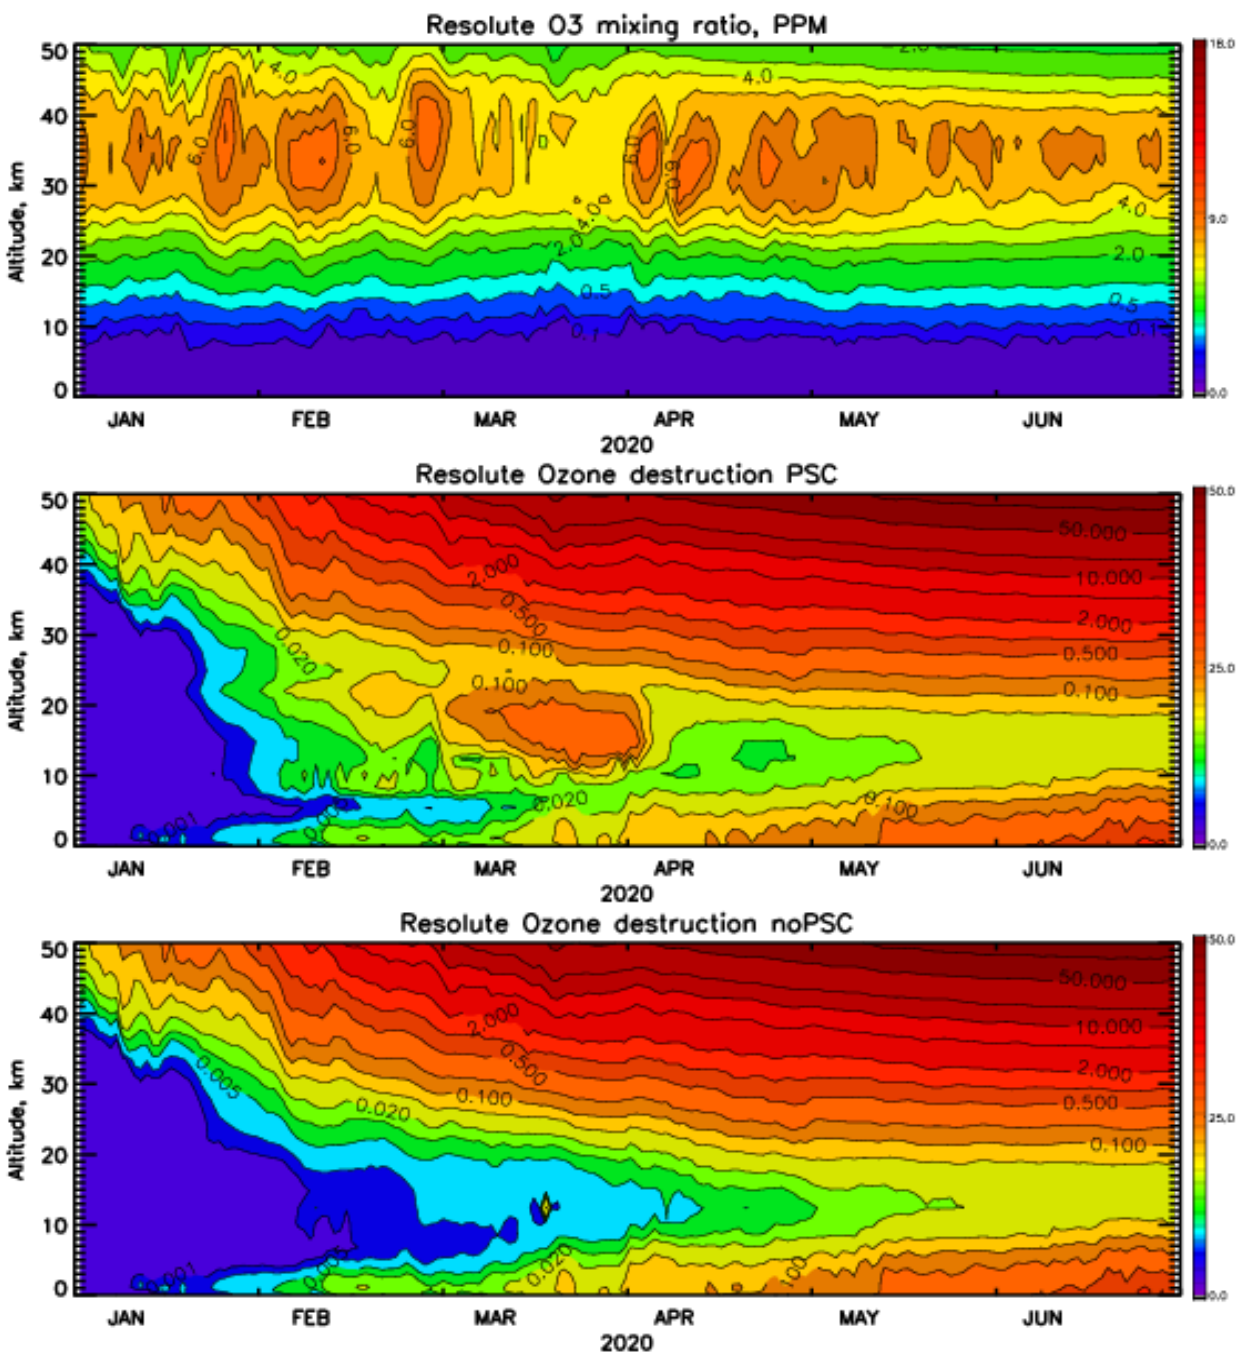
Figure 13. Ozone-mixing ratio at Resolute Station for the first half of 2020 ( top ), ozone destruction coefficient for PSC scenario ( middle ) and for noPSC scenario ( bottom ).